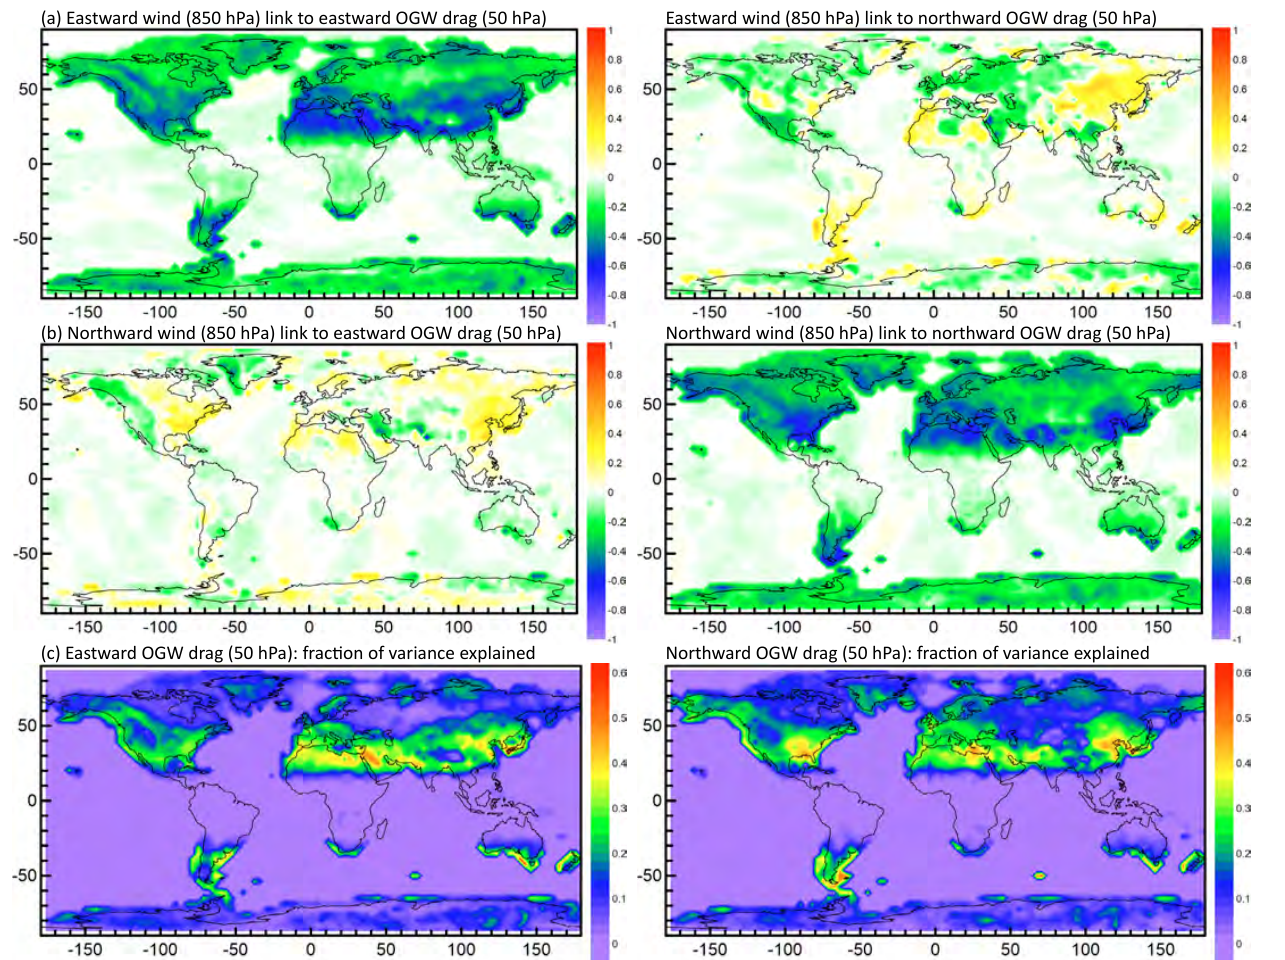
Figure 7. (a, b) Standardized regression coefficients between orographic gravity wave drag at the 50hPa level (predictand) and eastward and northward wind components at the 850hPa level (predictors), during the DJF season. (c) Coefficient of determination, i.e., the fraction of total variance of OGWD explained through the regression mappings by both components of wind at the 850hPa level. Analysis period: 1979–2010, daily data, DJF